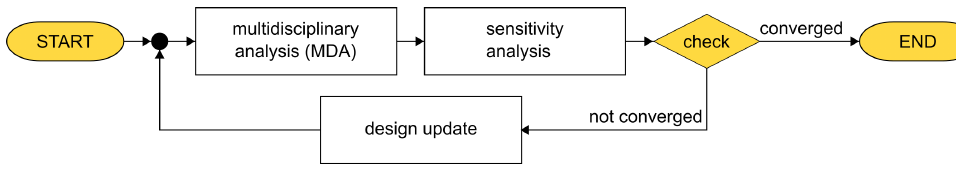
Figure 2. Structure of an MDO problem.